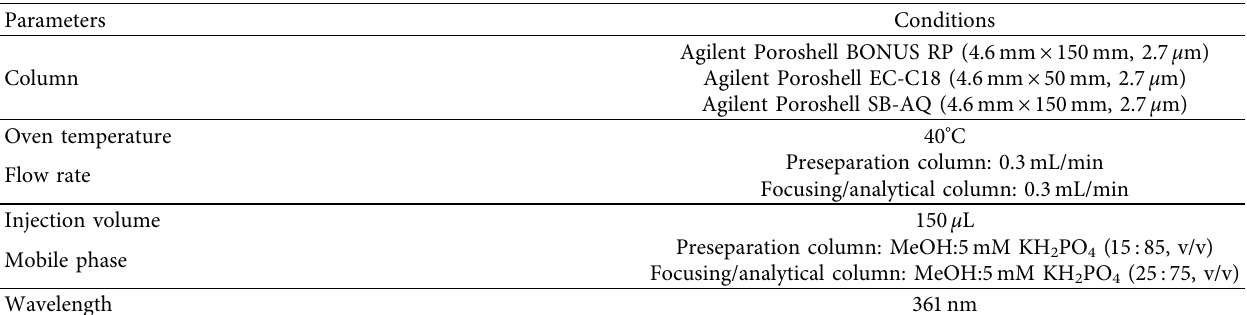
Table 1: HPLC analysis condition for cyanocobalamin